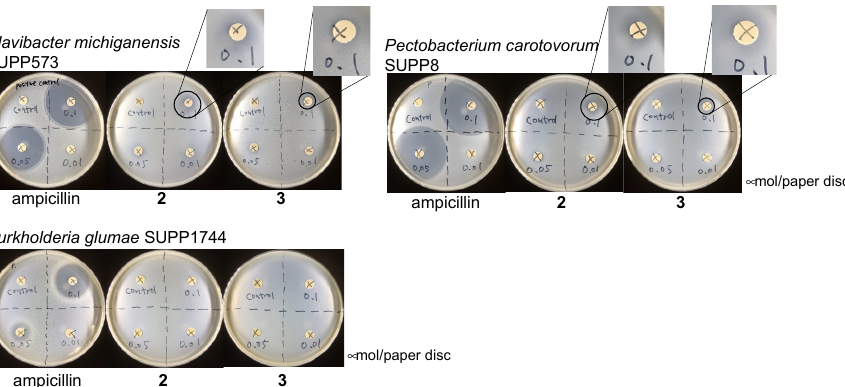
Figure 4. Activity of 2 and 3 against Clavibacter michiganensis , Pectobacterium carotovorum and Burkholderia glumae (positive control, ampicillin).